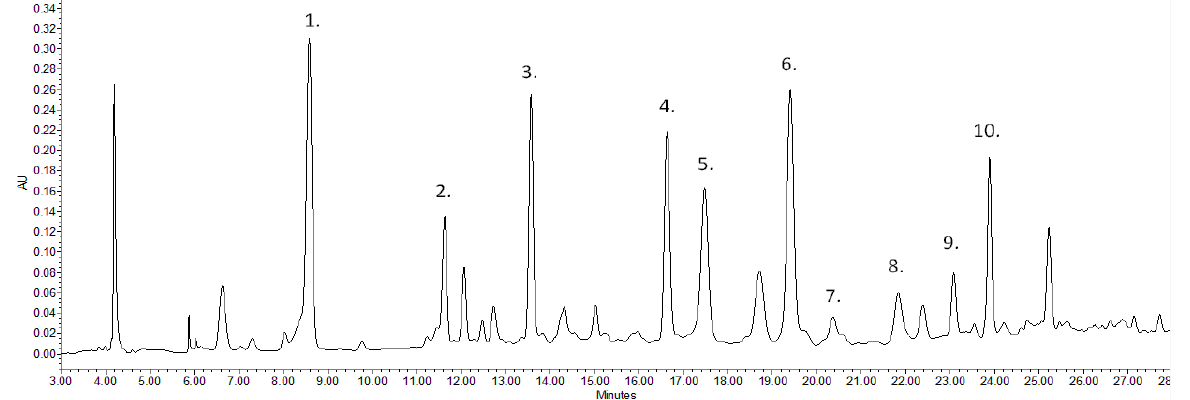
components (λ = 280 nm; (1) gallic acid, (2) neochlorogenic acid, (3) p-coumaric acid, (4) syringic